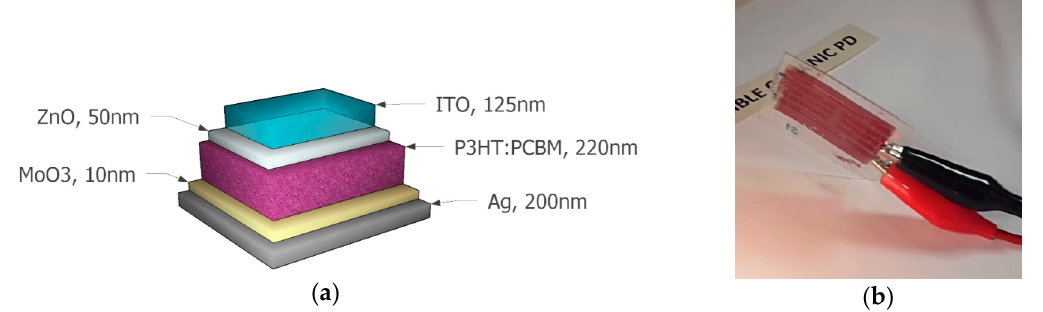
Figure 1. ( a ) OPD layer structure. The device area is 25 mm 2 ; ( b ) OPD in use.